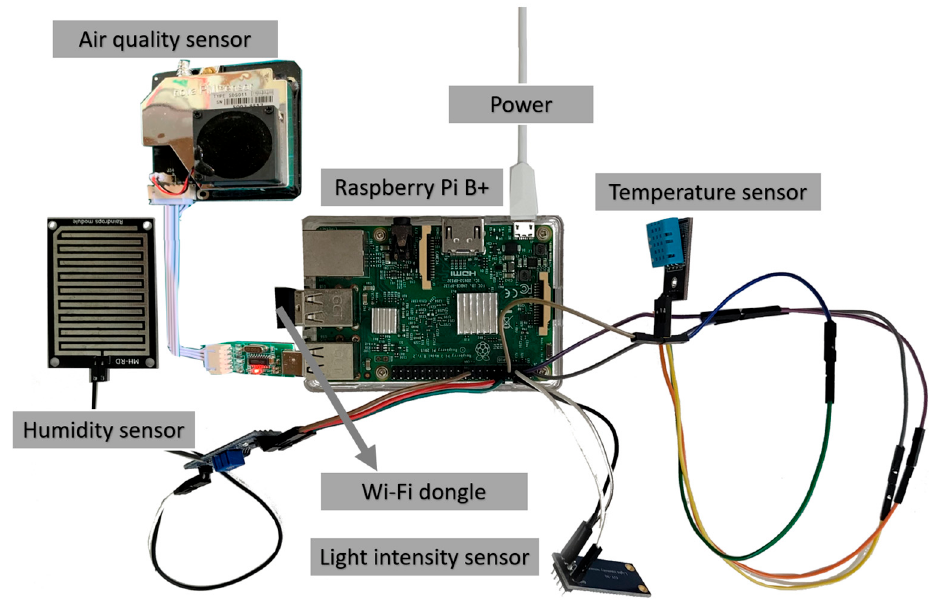
Figure 14. A Raspberry Pi B+ device equipped with Wi-Fi dongle USB and ambient sensors.